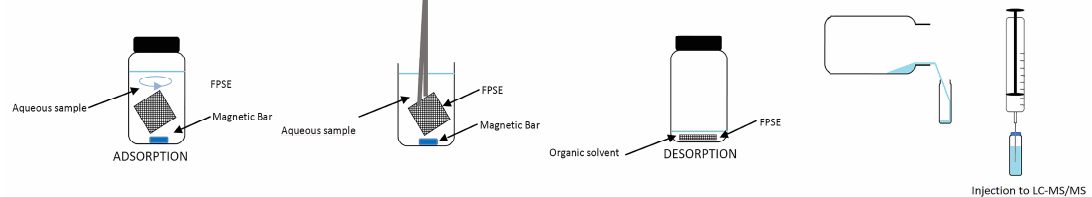
Figure 1. General procedure of fabric phase sorptive extraction (FPSE) methodology.